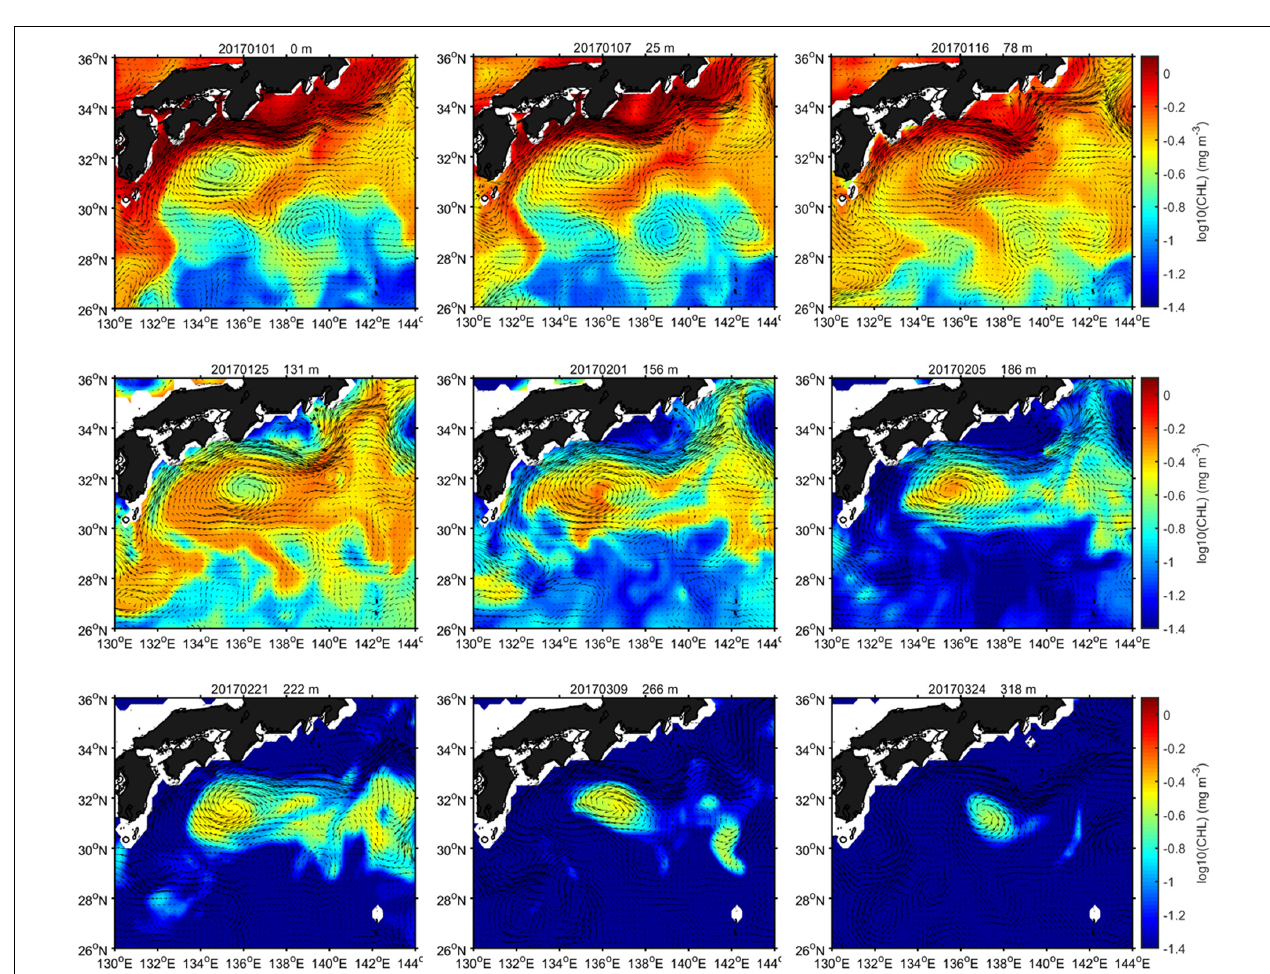
FIGURE 10 | Spatial distribution of CHL at different depths from 1 January to 24 March